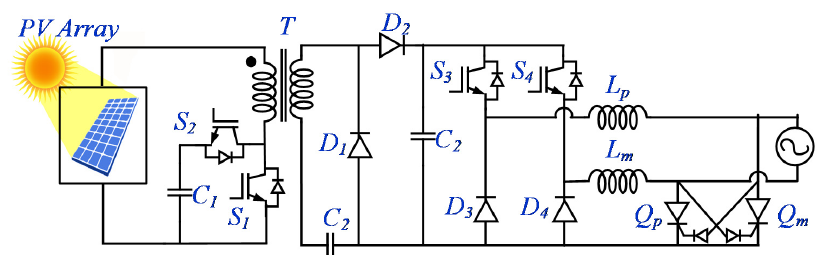
Figure 35. Active clamp DC–DC converter with single switch modulated inverter.